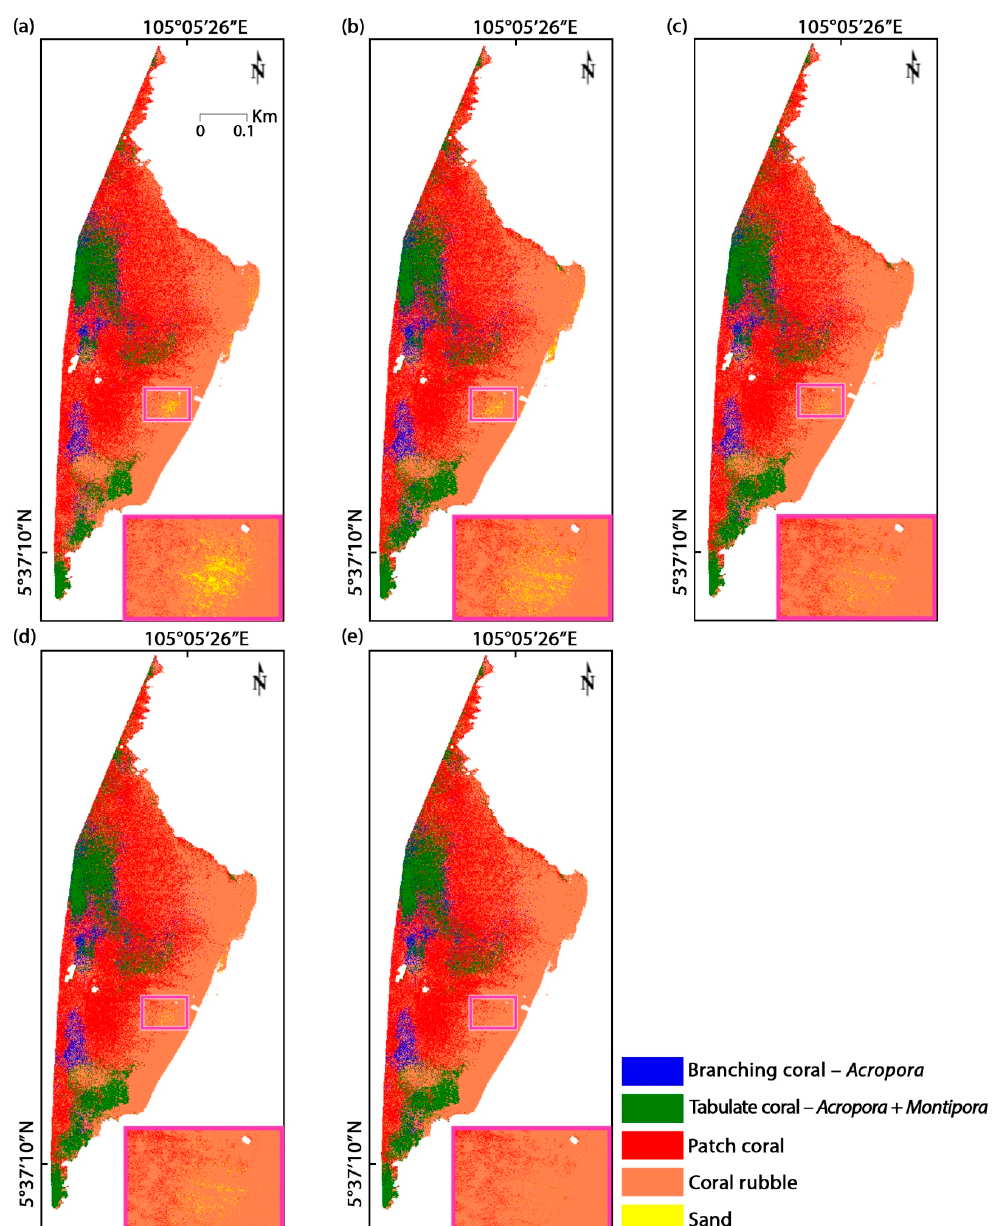
Figure 6. Benthic habitat classification maps of Site-1 (Pantai Pasir Cina) produced by supervised support vector machine (SVM) classification of UAV data. Strategy-1 was used to pre-process data. ( a ) Uncorrected image; images corrected using the methods proposed by ( b ) Lyzenga et al. [35], ( c ) Joyce [47], ( d ) Hedley et al. [28], and ( e ) Goodman et al. [29].